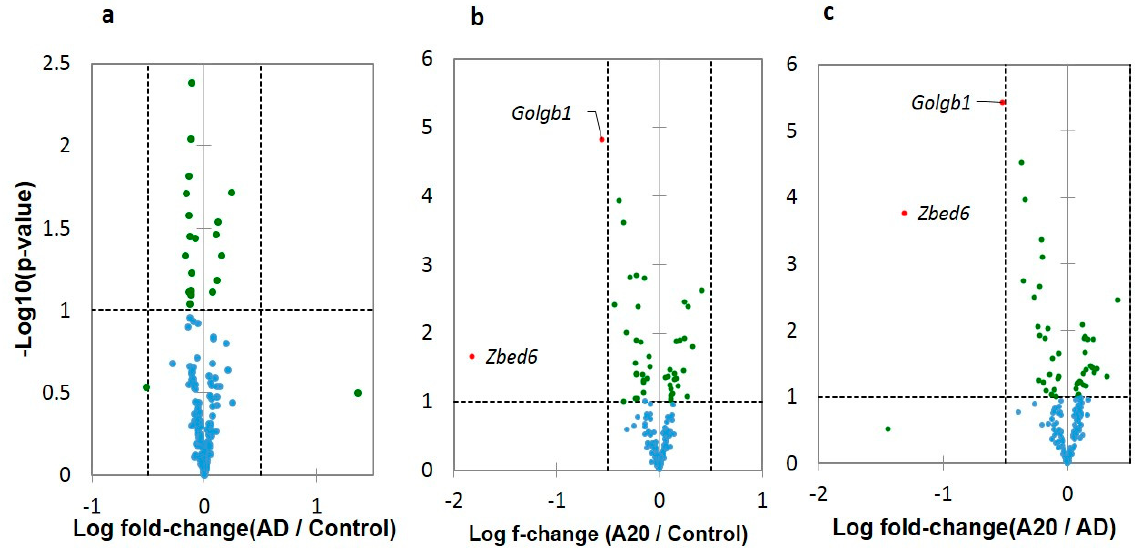
Figure 4. Volcano plots of the differential expression of DAS ES genes (Table S2a) created by Xlstat software (XLStat.com). ( a ) DEGs Log fold change in AD vs. control groups comparison; ( b ) DEGs Log fold change in AD vs. control groups comparison; ( c ) DEGs Log fold change in A20 vs. AD groups comparison. Golgb1 gene is Golgin b1 Golgi autoantigen and Zbed6 is Zinc Finger BED Domain-Containing Protein 6.